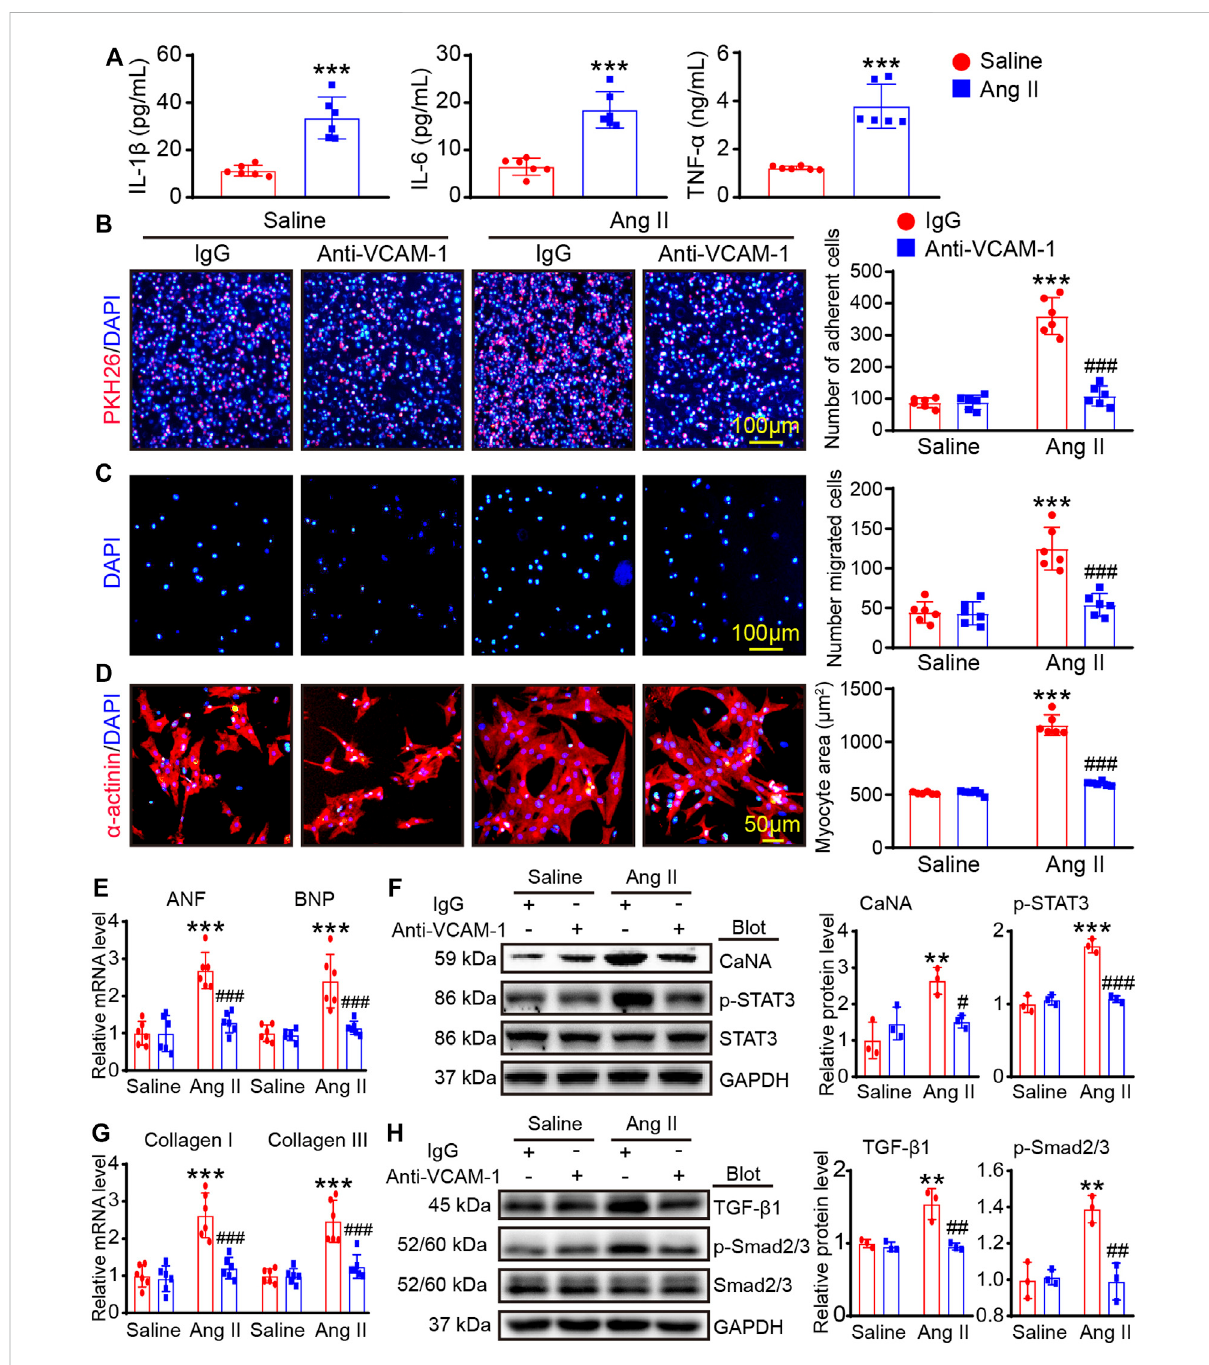
FIGURE 6 Blocking VCAM-1 inhibits macrophage adhesion and migration and reduces cardiomyocyte hypertrophy and myo fi broblast activation in vitro . (A) Thebonemarrow-derivedmacrophages(BMMs)werestimulatedwithAngII(100 nM)orsalinefor24 h.ELISAanalysisoftheIL-1 β ,IL-6andTNF- α levels ( n = 6) (B) HUVECs were pretreated an anti-VCAM-1 antibody (5 μ g/ml) or IgG control for 2 h and then stimulated with Ang II (100 nM) or salineforanadditional24 h.AdhesionofPKH26-labeled BMMs(red,left,scalebar:100 μ m)andanalysis ofadherentcells(right, n =6 fi elds) (C) Migration of BMMs (left). Scale bar: 100 μ m. Analysis of migrated cells (right, n = 6 fi elds) (D) HUVECs and BMMs were co-cultured and treated with anti-VCAM-1 (5 μ g/ml) and Ang II (100 nM) for 24 h. The supernatants were collected and added to CMs or CFs for 24 h. Cardiomyocyte size was determined using immunostaining with anti- α -actininantibody. (E) The mRNA levels ofANF and BNP inCMs wereanalyzed by qPCR analysis ( n = 6). (F) The protein levels of CaNA and p-STAT3 in lysates from CMs were determined by immunoblotting analysis (left), and quanti fi cation of relative protein level (right, n = 3independent experiments). (G) The mRNA levels of collagen Iand collagenIII inCFs were analyzed byqPCR analysis( n = 6). (H) The protein levels of TGF- β 1 and p-Smad2/3 in lysates from CFs were evaluated by immunoblotting analysis (left), and quanti fi cation of relative protein level (right, n = 3 independent